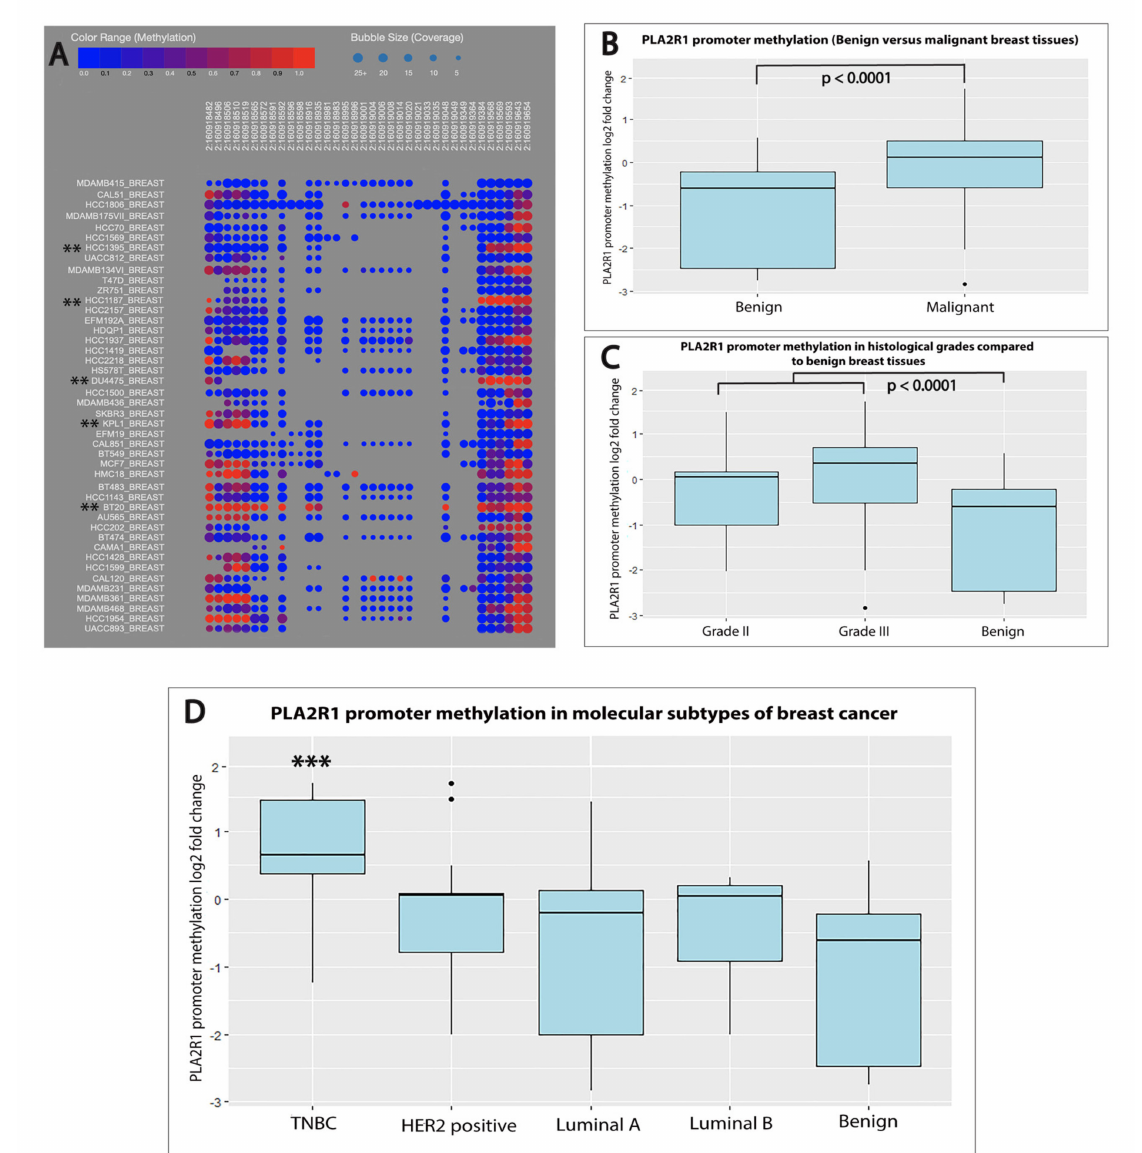
Figure 3. PLA2R1 promoter methylation in di ff erent grades and molecular subtypes of breast cancer compared to mammary fibroadenomas. ( A ) A bubble map created by the Cancer Cell Line Encyclopedia (CCLE) showing PLA2R1 methylation in 44 breast cancer cell lines. ** indicate the TNBC cell lines. ( B ) Boxplots depicting the hypermethylation of the PLA2R1 promoter in breast cancer tissues compared to breast fibroadenomas as control ( p < 0.0001). ( C ) Boxplots showing significant hypermethylation of the PLA2R1 promoter in Grade II ( p = 0.014) and Grade III ( p < 0.0001) breast cancer compared to benign control tissues. ( D ) Boxplots showing that methylation of the PLA2R1 promoter was significantly elevated ( p < 0.0001) in TNBC when compared with benign breast fibroadenomas. *** indicate significant di ff erence in comparison to benign